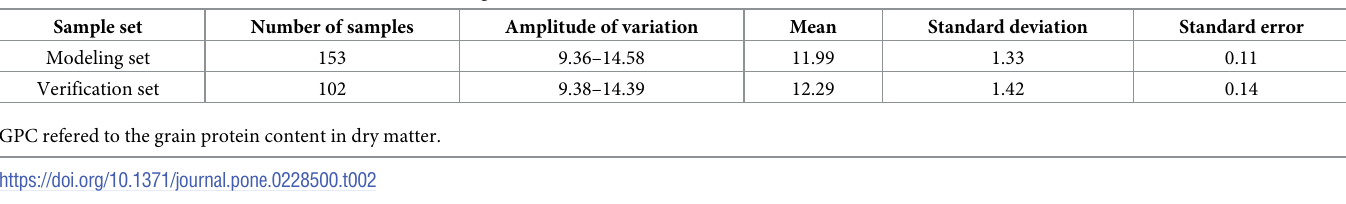
The structure of the PLS model was based on the PLS algorithm and the four vegetation indi- ces with the principal components number of 4. All these were sensitive to the prediction of wheat GPC and could be easily extracted and calculated from the HJ-CCD image. These were NDVI, structure intensive pigment index (SIPI), plant senescence reflectance index (PSRI) and EVI. All these were considered as the independent variables and the GPC was the depen- dent variable for the PLS model of predicting the GPC. The GPC model constructed by the modeling set and the HJ-CCD images during the three days 2016-05-02, 2017-04-24, and